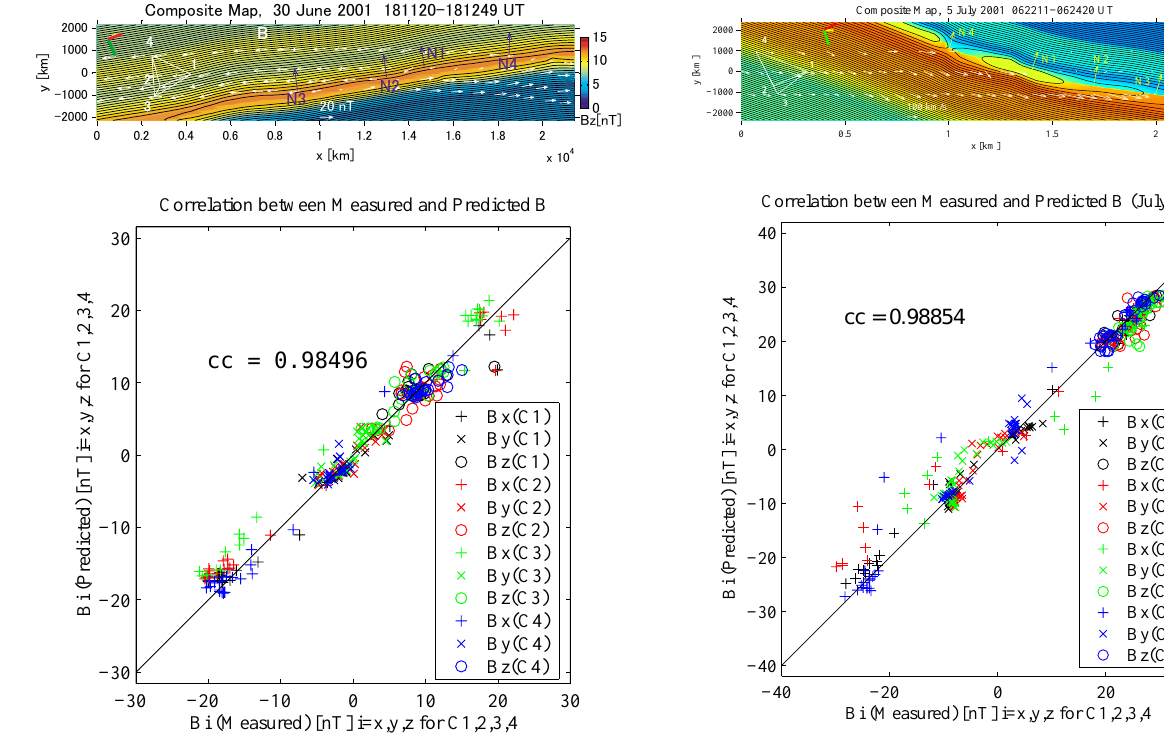
Fig. 9. Composite map produced from C1 and C4 measurements, and associated scatter plot for a magnetopause crossing on 5 July 2001, studied by Hasegawa et al. (2004). White arrows now repre- sent the velocity vectors transformed into the HT frame. GSE coor- dinate axes of the map are x =(0.7769, 0.2793, 0.5643), y =(0.3692, − 0.9280, − 0.0490), z =(0.5100, 0.2464, − 0.8241). from C3 data for the second one, these velocity values are the same as used by Hasegawa et al. (2004). The resulting maps are shown in Figs. 9 and 10, respectively, along with the cor- responding scatter plots. The white arrows now represent ion bulk velocities, measured by CIS/HIA on board C1 and C3 and by CIS/CODIF on board C4, and transformed into the HT frame. Figure 9, produced from C4 and C1, shows that, at this time, the boundary was more or less of a TD-type, although two thin magnetic islands are present, separated by an X point at (x, y) =(10 000, 1000) km. In the HT frame, the velocities are small in the magnetosheath and much larger in the magnetosphere. This implies that the HT frame was well anchored in the magnetosheath plasma and that mag- netic coupling between the two sides was not strong. How- ever, the slope of the Wal´en regression line from C1 is +0.568 (Hasegawa et al., 2004), suggesting incipient reconnection at the X . The velocity arrows are not always well aligned with the field lines, in particular in the magnetosphere. The expla- nation for these deviations may lie in part in the intrinsic time dependence of the configuration and in part in the accuracy of the measurements. The optimal invariant axis has GSE components z =(0.5100, 0.2464, − 0.8241), and deviates from